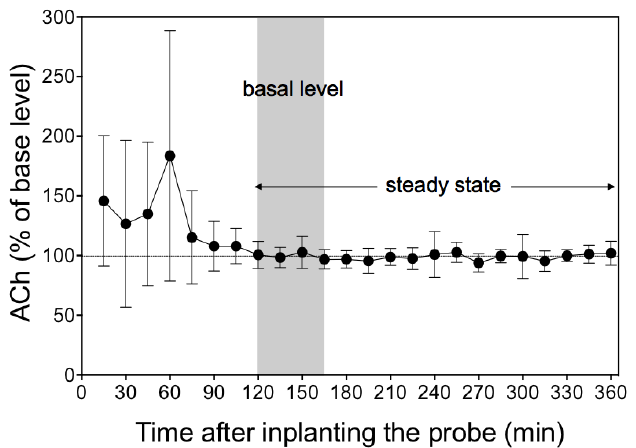
Figure 4. The time course of changes in acetylcholine (ACh) levels in the dialysate after probe implantation. The solid grey bar indicates 3 fractions for basal level. Acetylcholine concentration in the dialysate maintained an almost steady-state level for 240 min after probe implantation. The values represent mean ± SD of 6 rats and are expressed as percentages of the basal